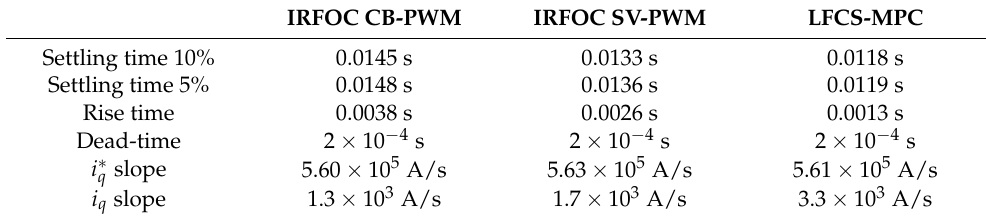
Figure 13. Test 4. Speed-step response at same sampling time for IRFOC CB-PWM ( left ), IRFOC SV-PWM ( center ) and LFCS-MPC ( right ). From top to bottom: ( a ) Mechanical speed, ( b ) d − q currents and ( c ) voltage of the phase a 1 . Table 9. Time-response indices for Test